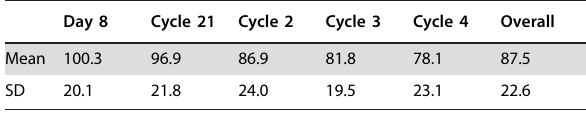
Determinations were taken in 14 patients. The difference between the first and fourth mean concentrations was statistically significant ( p =0.0118). SD, standard deviation. doi:10.1371/journal.pone.0000098.t004 .